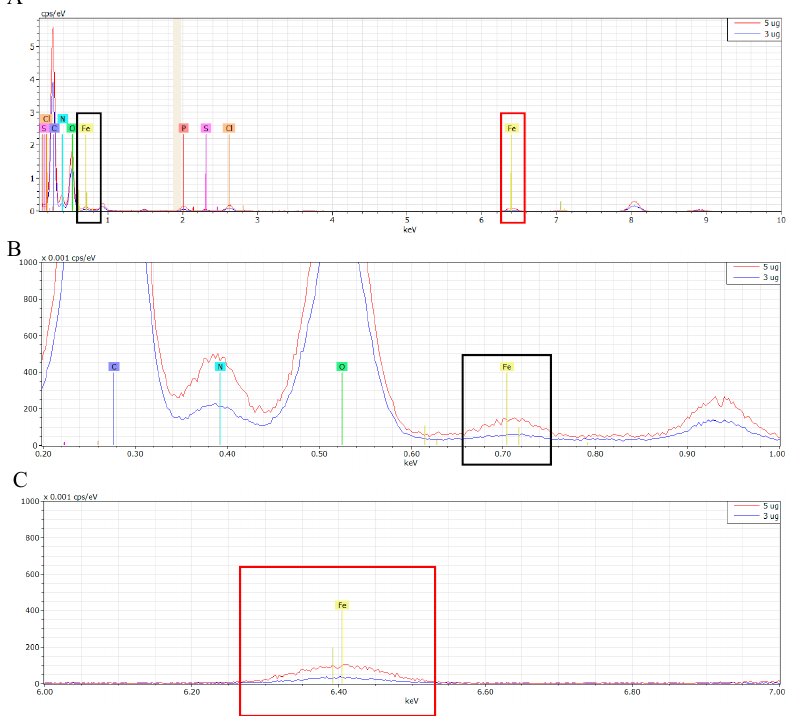
Figure 10. Overlapped spectra of the elemental mapping of nanoMIL-89. PAECs were treated with 3µg/mL (blue line) and 5µg/mL (red line) of nanoMIL-89, respectively. ( A ) showing the full spectra of elements signal (cps/eV) with respect to energy signal (keV), zoomed in ( B ) to show the L ⍺ Fe signal ( ≈ 0.705 keV) and in ( C ) to show the K ⍺ Fe signal ( ≈ 6.398 keV) for both samples. The intracellular iron signal was measured using Bruker EDS installed in a Talos TEM system.